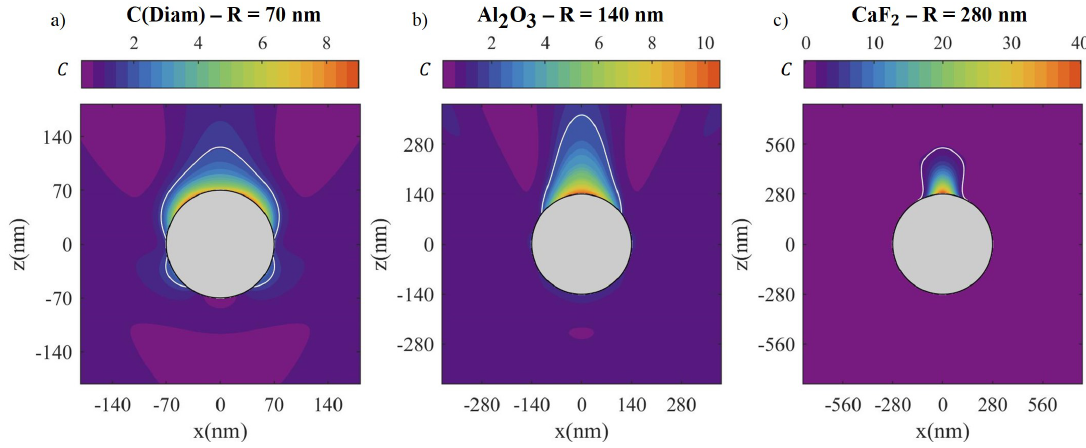
Figure 7. Spatial distribution of the OCD in the proximity of a spherical NP with a ( a ) 70 nm radius of diamond at 4.6 eV, ( b ) 140 nm radius of Al 2 O 3 at 4.1 eV and ( c ) 280 nm radius of CaF 2 at 5.7 eV. With a white line, the section where (cid:104) C (cid:105) > 2 is indicated. Table 2. Numerical information concerning sphere surface distribution of OCD